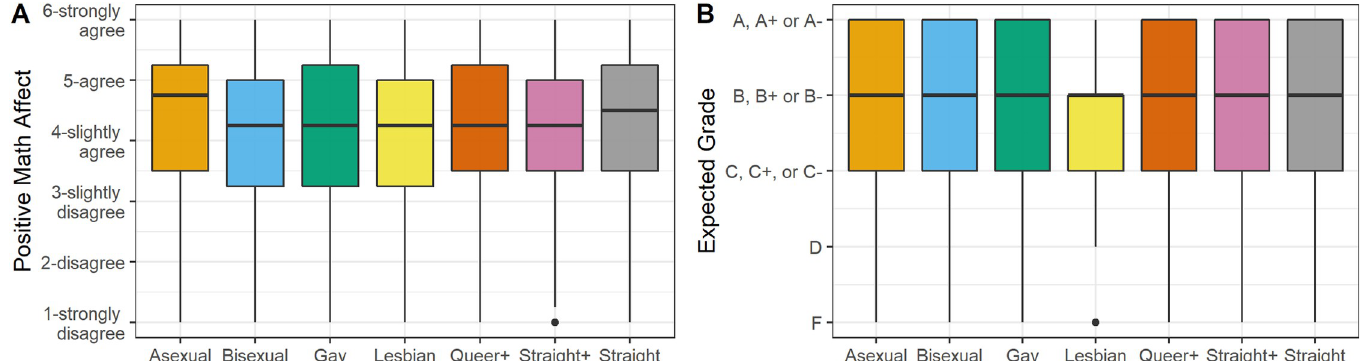
Fig 4. Boxplot with mean of Math Affect (A) and Expected Grade (B) across sexual identity.